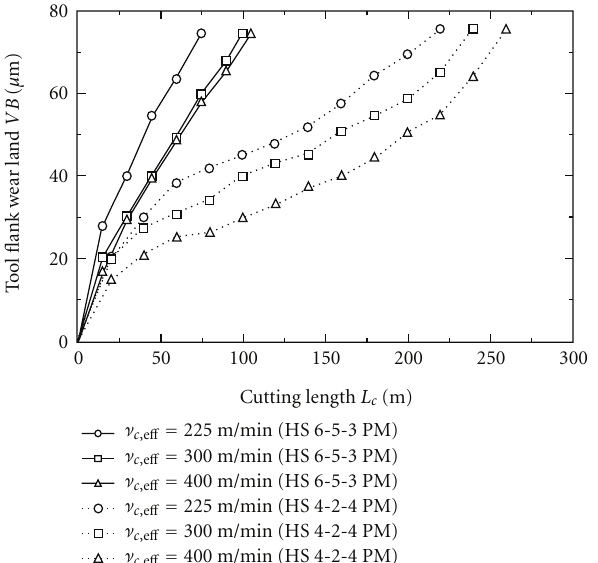
Figure 13: Influence of varied work piece material and varied e ff ective cutting speed on the tool flank wear land.